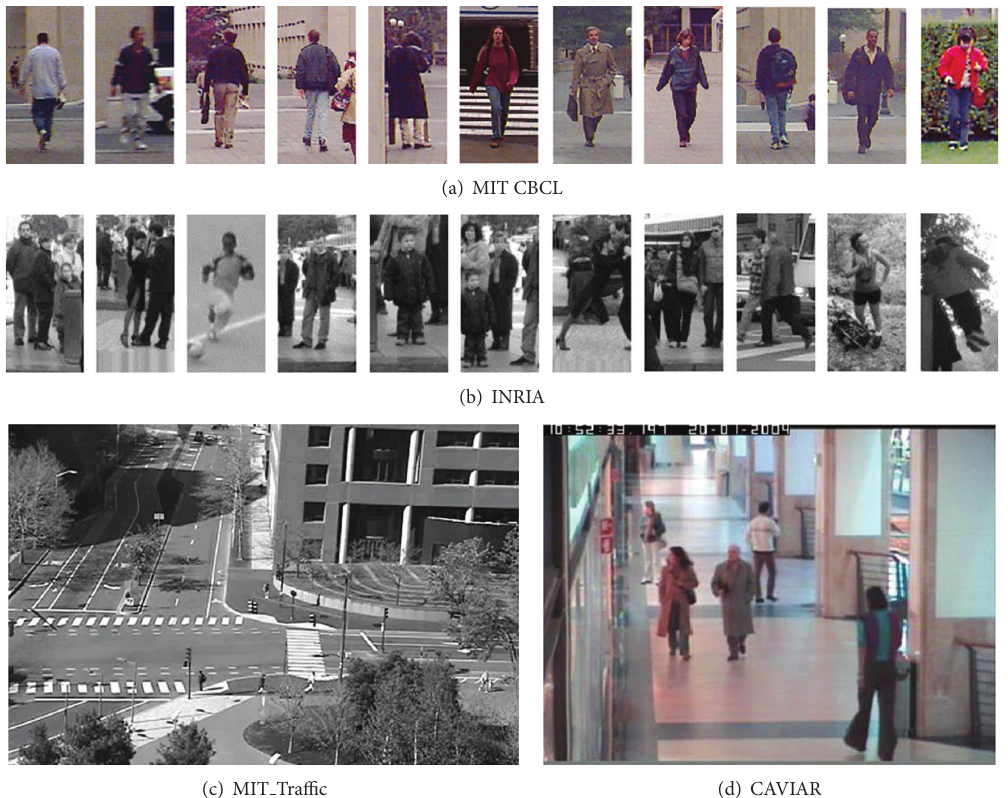
Figure 1: Some samples and example images (cropped) from four